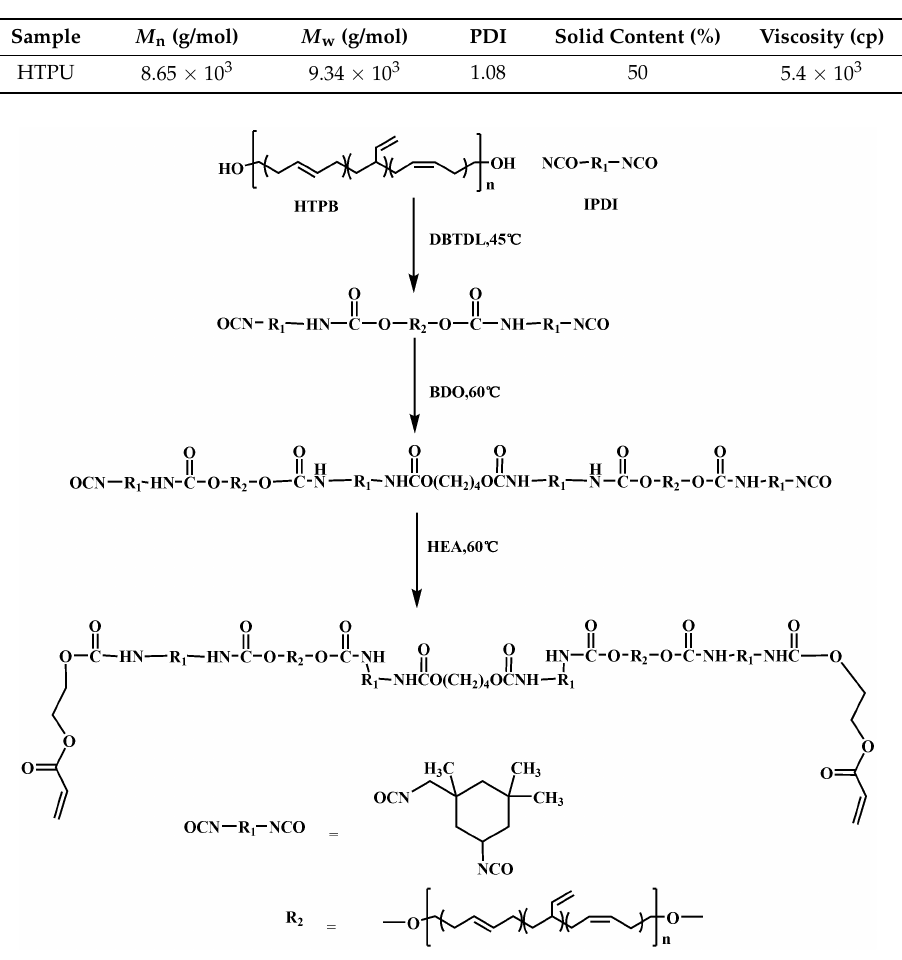
Table 1. The molecular weight, molecular weight distribution and viscosity of HTPU.